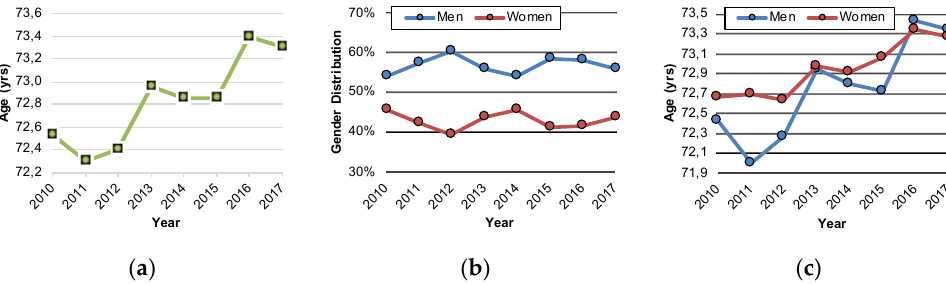
Figure 3. Dynamics of PSP (G23.1) inpatient case numbers and gender distribution from the year 2010 to 2017 in Germany. ( a ) Distribution of diagnoses according to gender; ( b ) distribution of diagnoses according to age at examination; ( c ) mean age of patients at examination differentiated by gender.